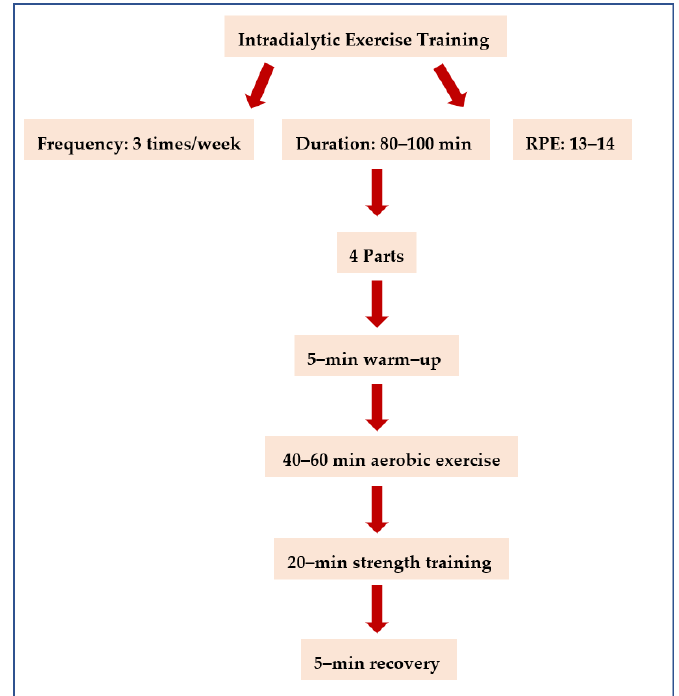
Figure 1. Flowchart of the intradialytic exercise program.